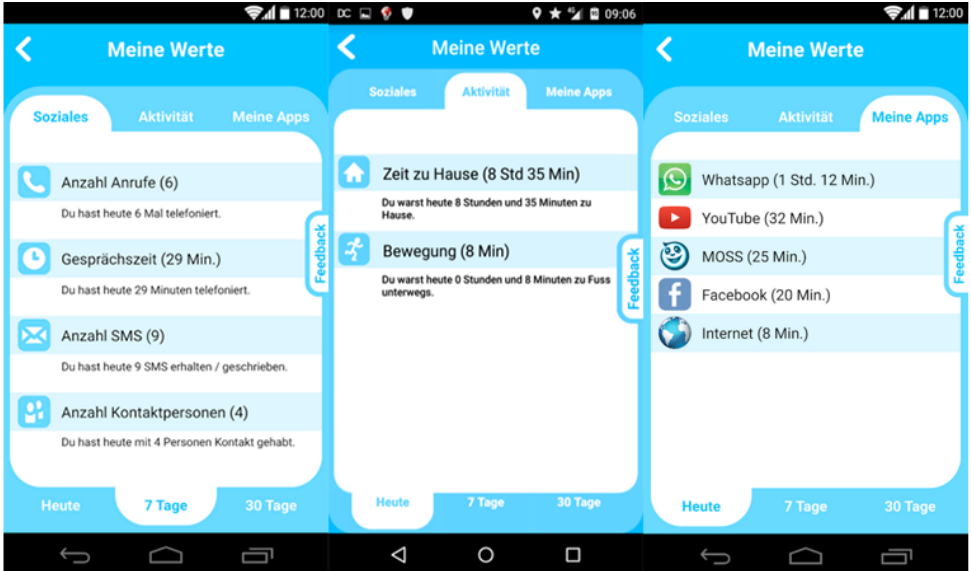
Figure 2. Social activity, physical activity, and used app screens of the Mobile Sensing and Support (MOSS) app. Note: The initial user interface was in German, the first screen shows number of calls, total time of calls, amount of SMS text messages, and number of persons contacted over the last 7 days. The second screen shows time spent at home and time spent moving during the current day.